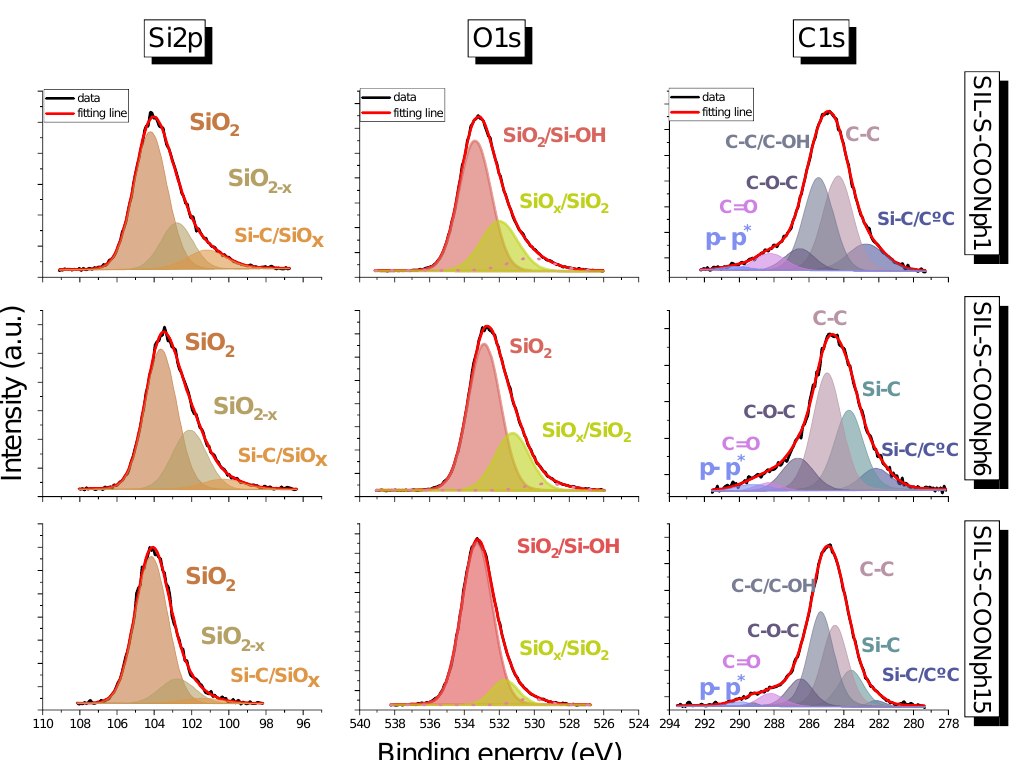
Figure 4. Deconvoluted high-resolution Si2p, O1s, and C1s X-ray photoelectron spectra of the 2-naphthalene methanol- containing samples.